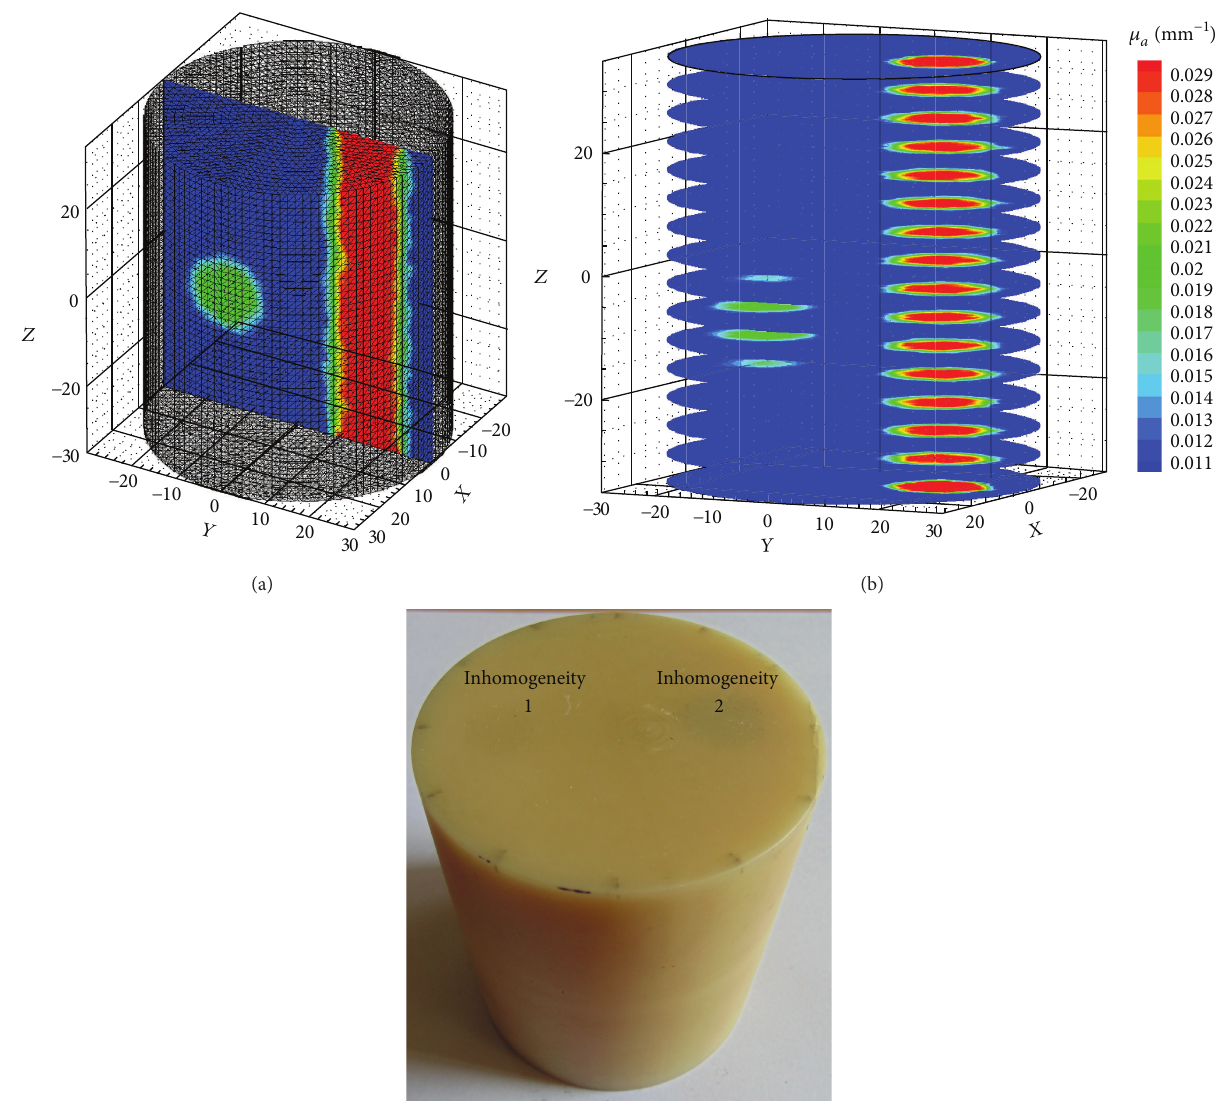
Figure 1: (a) The reference phantom with two inhomogeneities ( 𝜇 𝑎 = 0.02 mm −1 and 𝜇 𝑎 = 0.03 mm −1 ), (b) planes along the 𝑍 -direction, and (c) experimental phantom with two